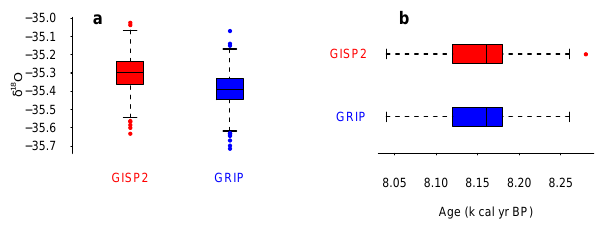
Age (k cal yr BP)used only GRIP data used both GISP2 and GRIP Figure6. Plotsoftheinterquartileranges(IQR;correspondingtothewidthofthe50%crediblebandinFig.5) ofthemarginalposteriordistributionsof x g onabidecadaltimegridovertheperiodof0to11kcalBPatcore (a) GISP2and (b) GRIP.Themainfeaturesfromtheseplotsare:(i)interquartilerangesoftheseparatemodels arealwayshigherthanthoseofthejointmodel;(ii)thegapsofthedifferencesin (a) areconsistentlylargerthan thosein (b) ;(iii)thereareseveralspikes;(iv)aslighttendencyforincreasedIQRfurtherbackintime.Seethe